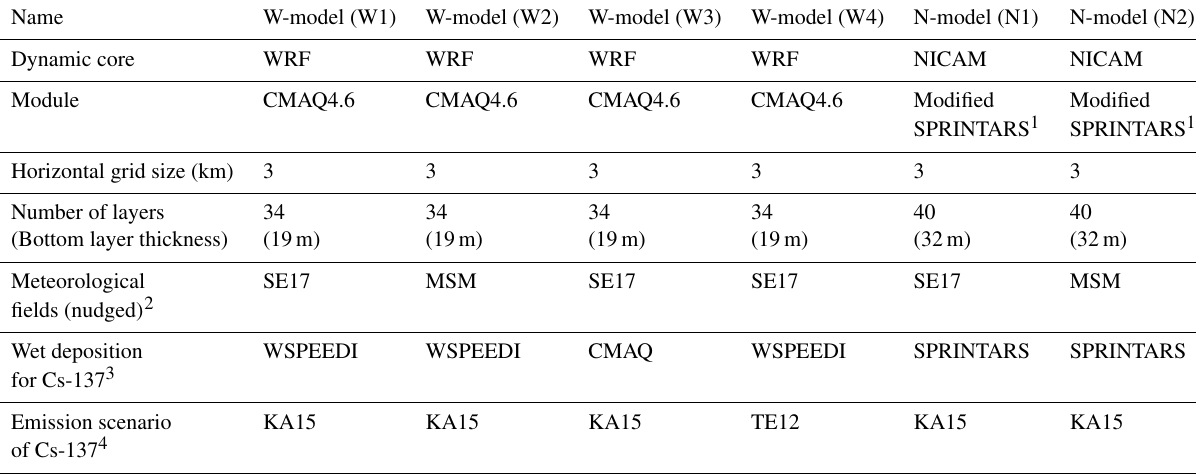
Table 1. Brief model description and the design of the